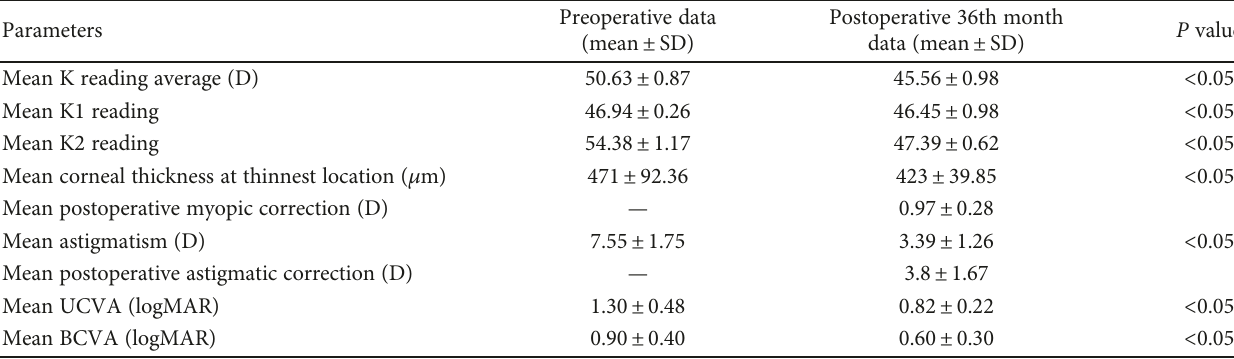
Table 2: CXL PLUS preoperative and postoperative data summary at the end of the 3-year follow-up.